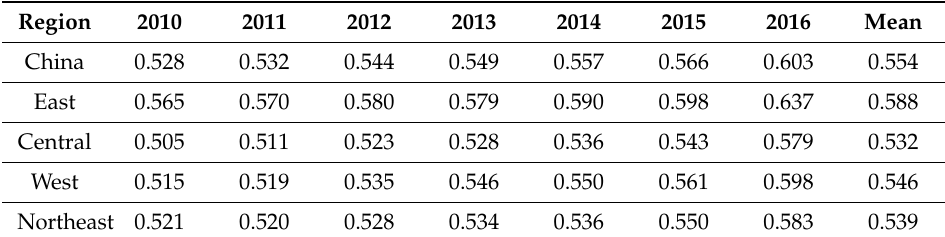
Table 3. Trends of ULUE in China during